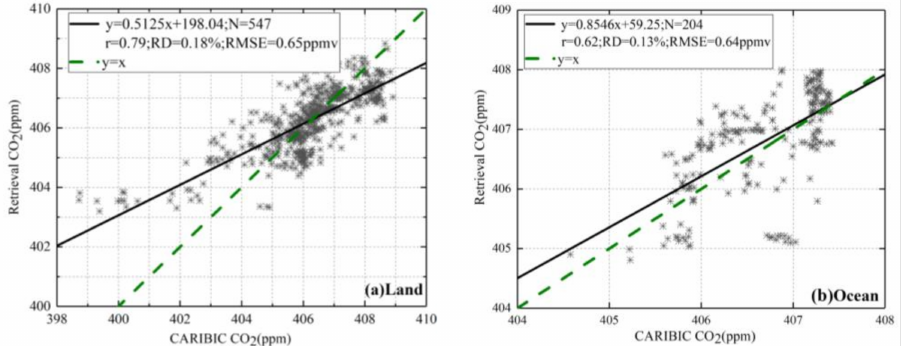
Figure 8. CO 2 comparison between smoothed CARIBIC and CrIS retrievals in ( a ) land and ( b )